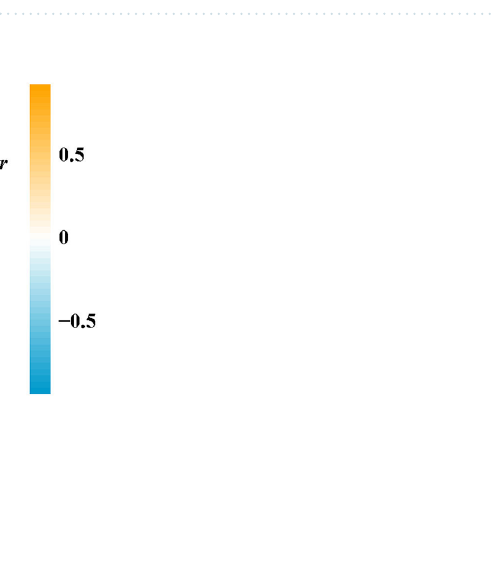
Figure 6. Comparison of clostridial variations using the LEfSe online tool for alfalfa silage at 56 days (CK, control; LP, Lactobacillus plantarum ; S, sucrose; LP + S, the addition of both sucrose and Lactobacillus plantarum ).